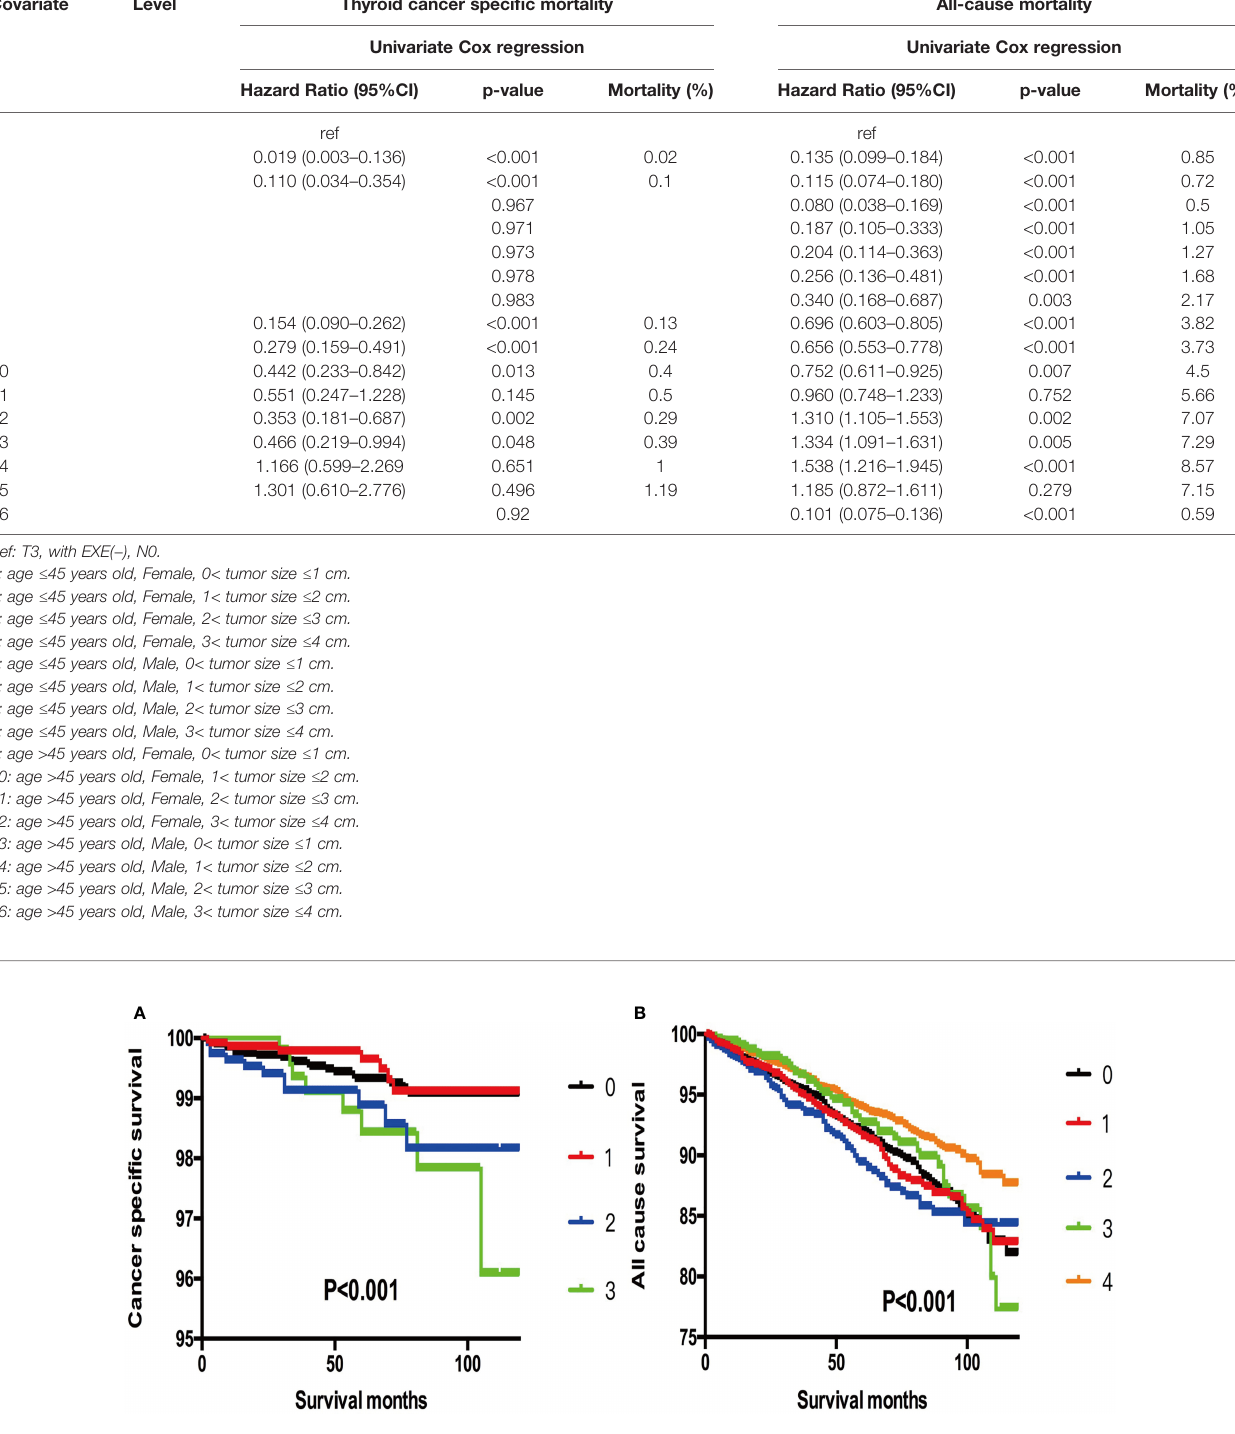
FIGURE 2 | (A) Kaplan-Meier curves among patients strati fi ed by tumor size for cancer-speci fi c mortality (Log rank test, p < 0.001). 0 For patients with thyroid cancer>4 cm and without gross extrathyroidal extension (clinical T3) and no clinically apparent metastatic disease to nodes (clinical N0) or distant sites (clinical M0). 1 Male, > 45 years old, tumor size 1-2 cm. 2 Male, > 45 years old, tumor size 2-3 cm. 3 Male, > 45 years old, tumor size 3-4 cm. (B) Kaplan-Meier curves among patients strati fi ed by tumor size for all-cause mortality (Log rank test, p < 0.001). 0 For patients with thyroid cancer>4 cm and without gross extrathyroidal extension (clinical T3) and no clinically apparent metastatic disease to nodes (clinical N0) or distant sites (clinical M0). 1 Male, > 45 years old, tumor size 0-1 cm. 2 Male, > 45 years old, tumor size 1-2 cm. 3 Male, > 45 years old, tumor size 2-3 cm. 4 Male, > 45 years old, tumor size 3-4